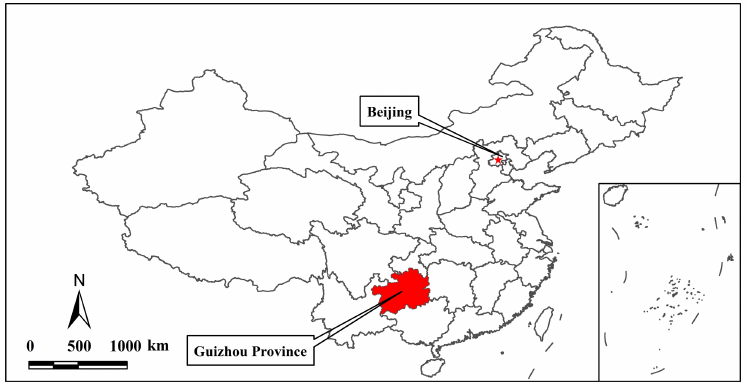
Figure 1. Location of Guizhou Province.